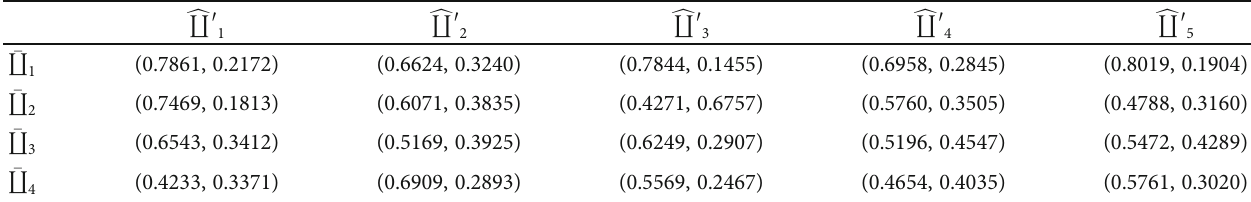
Table 4: IF-aggregated values ~ χ